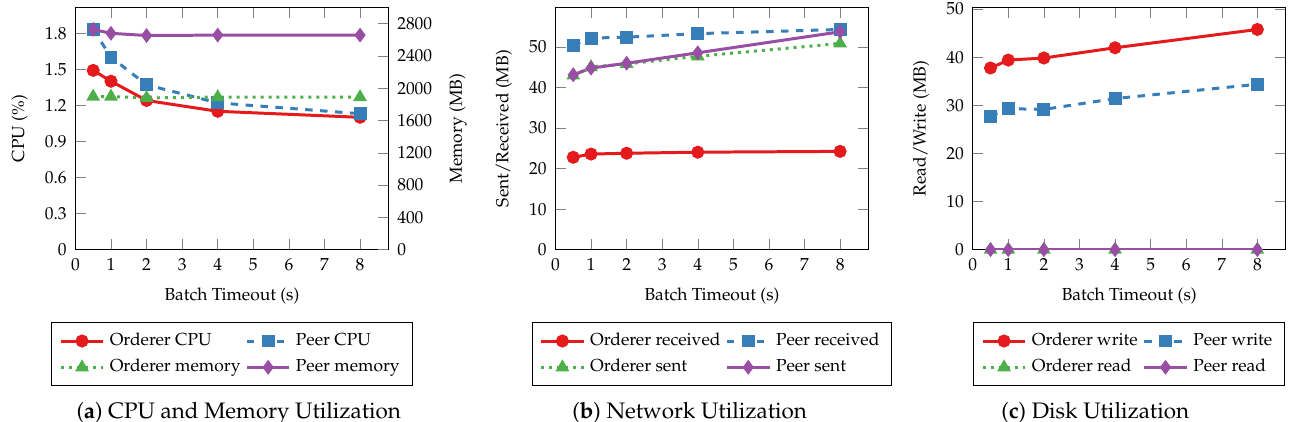
Figure 17. The average CPU and memory usage ( a ), total data received from and sent to the network ( b ), total data written to and read from disk ( c ) of orderer and peer nodes for handling “querying a service request” operations with varying batch timeouts.